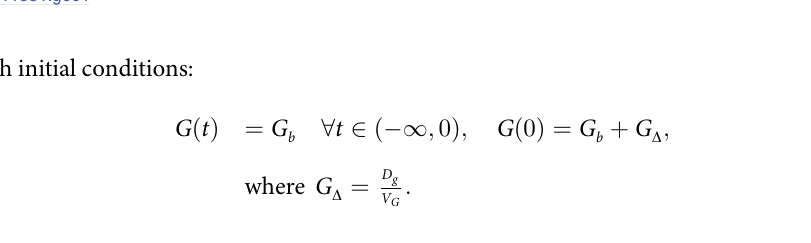
Fig 1. Schematic representation of the Compact Model . Glucose Plasma concentrations arise following an IntraVenous Glucose Dose. Input to plasma Glucose compartment comes also from the liver which produces glucose by means of gluconeogenesis and glycogenolysis processes, while elimination occurs by an independent (first order elimination rate) and dependent-insulin mechanism (second order tissue uptake). High plasma glucose concentrations enhance insulin release in plasma, while insulin is cleared with a first order elimination rate.